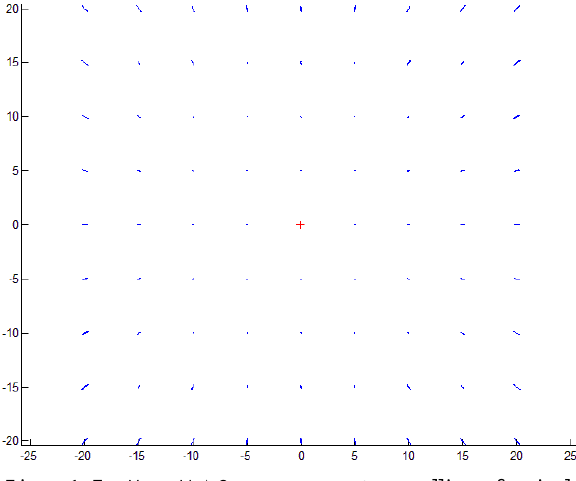
Figure 1. ExoMars WACs measurement error ellipses for